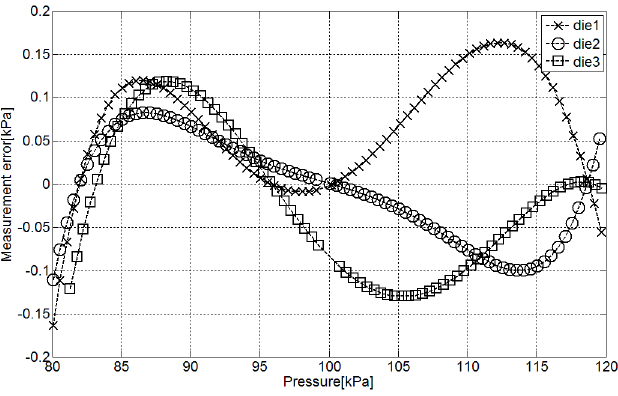
Figure 10. Error in the pressure estimation with the fabricated pressure